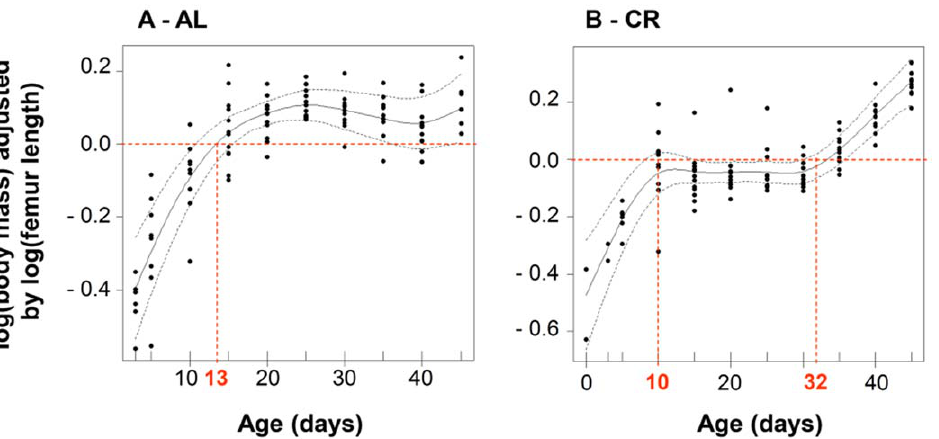
Figure 3. Effect of food availability to lactating mothers on the variation of offspring body condition with age. Non-linear temporal variation of log (body mass) residuals [adjusted for log (femur length)] of offspring from females fed ad libitum (AL, panel A) and from calorie restricted females (CR, panel B). The curve describing the age effect (solid line) was extracted from GAMMs. Dashed lines depict 2 standard error point-wise confidence bands, and black dots provide partial residuals. In panel A., red dashed line points the date at which body condition is above average, thereby signing a sustained high body mass increase relative to body size growth. In panel B., red dashed lines and bold labels delimit the period of delayed growth.